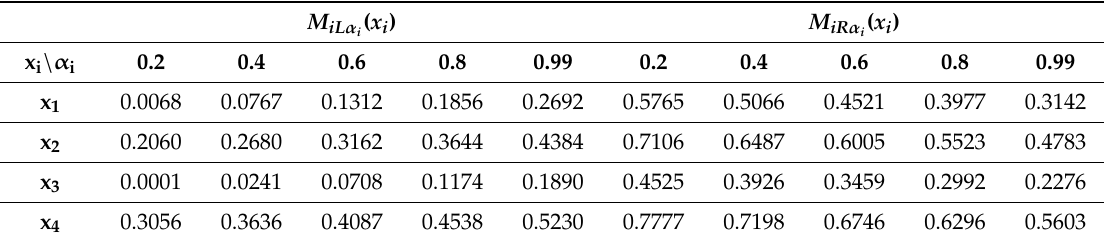
Table 1. Fuzzy densities generated by each alpha